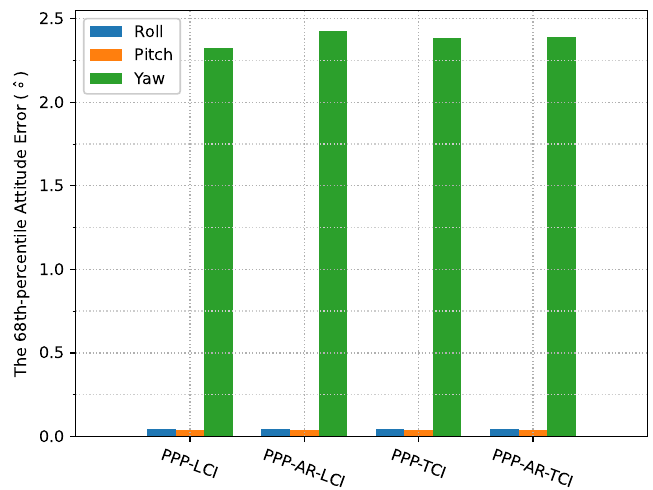
Figure 13. PPP/INS positioning attitude error RMS of the train test on 7 March 2022.